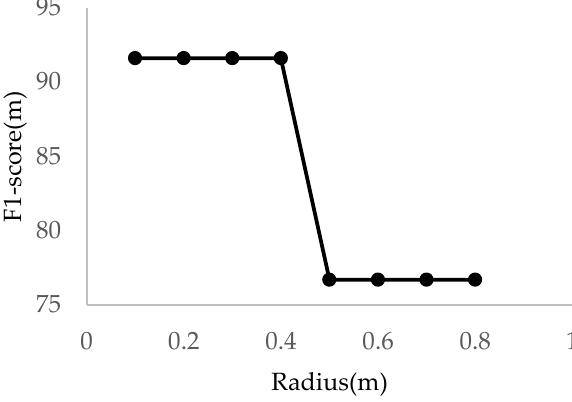
Figure 16. F1-score values for different radius values.